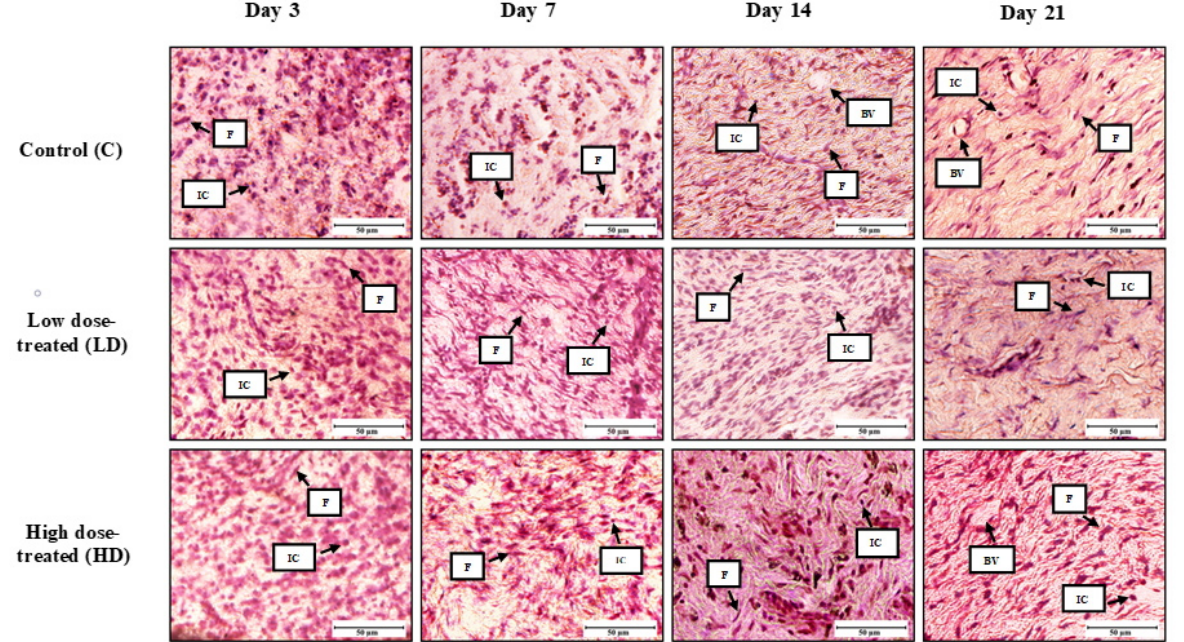
Figure 4. Histopathological characteristics of wound granulation tissue on post-wounding days 7, 14 and 21 stained with hematoxylin. Day 3 control and treated rats: presence of inflammatory cells is evident. Collagen deposition observed in the high dose treated animals at day 14. BV: blood vessels; F: fibroblasts; IC: inflammatory cells (x400).